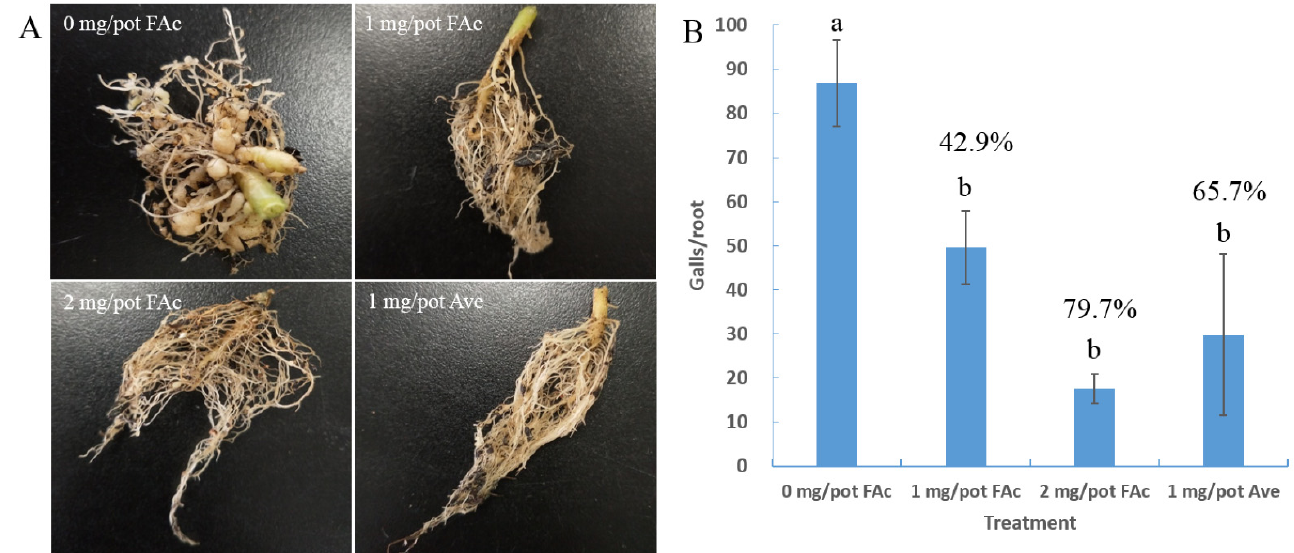
Figure 1. Control efficiency of FAc against M. incognita in pots. ( A ) Roots of tomato plants after treatment with FAc or avermectin (Ave). ( B ) Control efficiency of FAc and Ave against M. incognita in pots. Data are shown as the mean ± standard error ( n = 5), and different lowercase letters indicate significant difference among treatments by LSD test ( p < 0.05). The numbers above the lowercase letters indicate the control effect of each group compared with the control. Control effect (%) = ((galls in control − galls in treated)/galls in control) × 100.